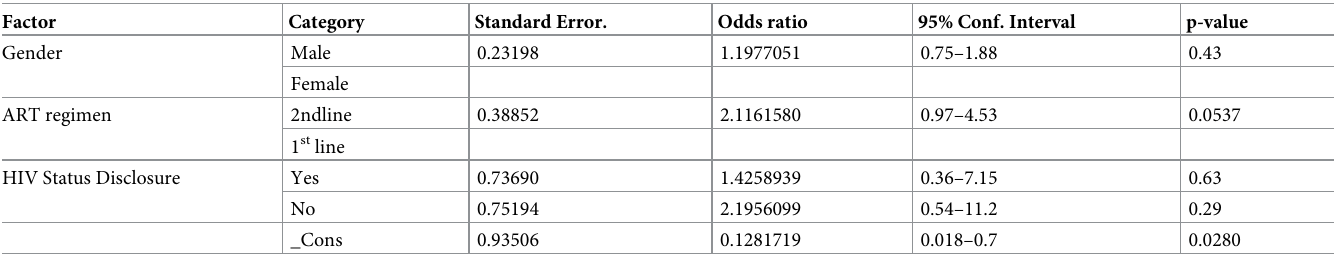
Table 4. Multivariate logistic regression model of factors associated with ART adherence. Factor Category Standard